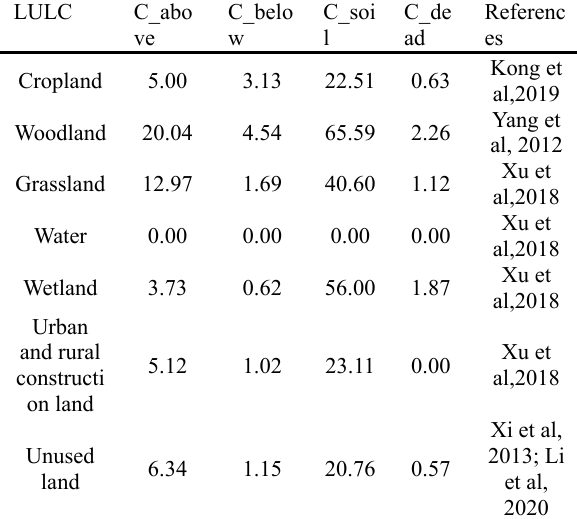
Table 2 . InVEST carbon stock model with four types of carbon pools.